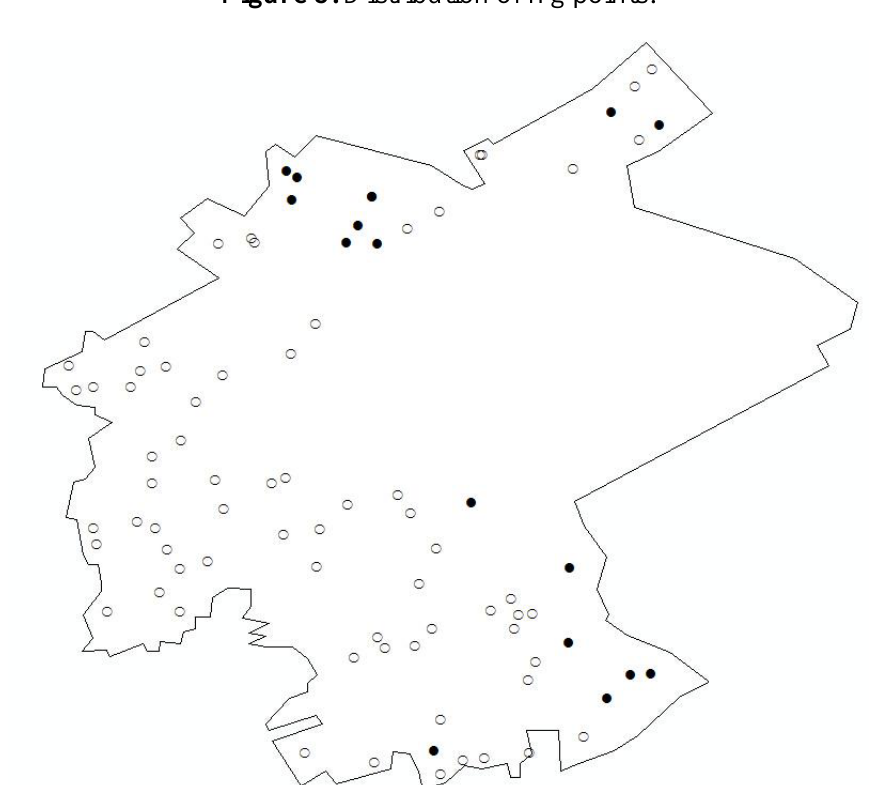
Figure 5. Distribution of Hg